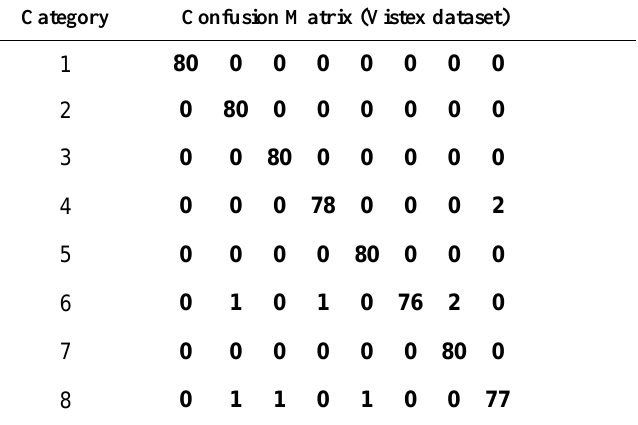
Table 8. Confusion matrix based on MIT-Vistex dataset